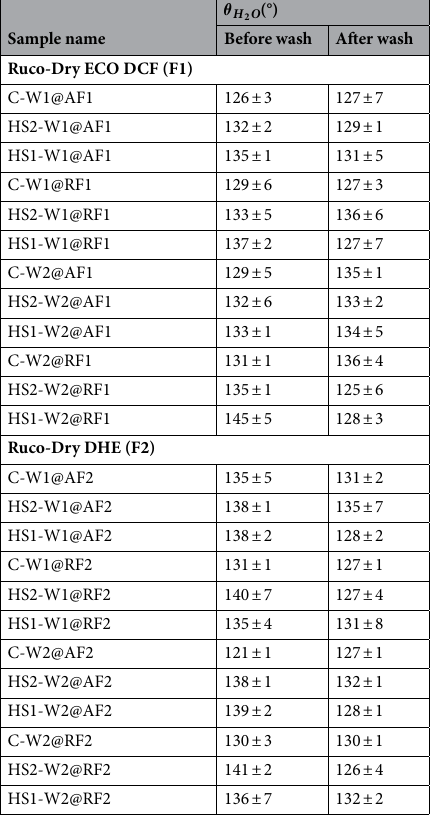
Table 3. Fastness of hydrophobic finishes to washing based on water contact angle of the finished wool